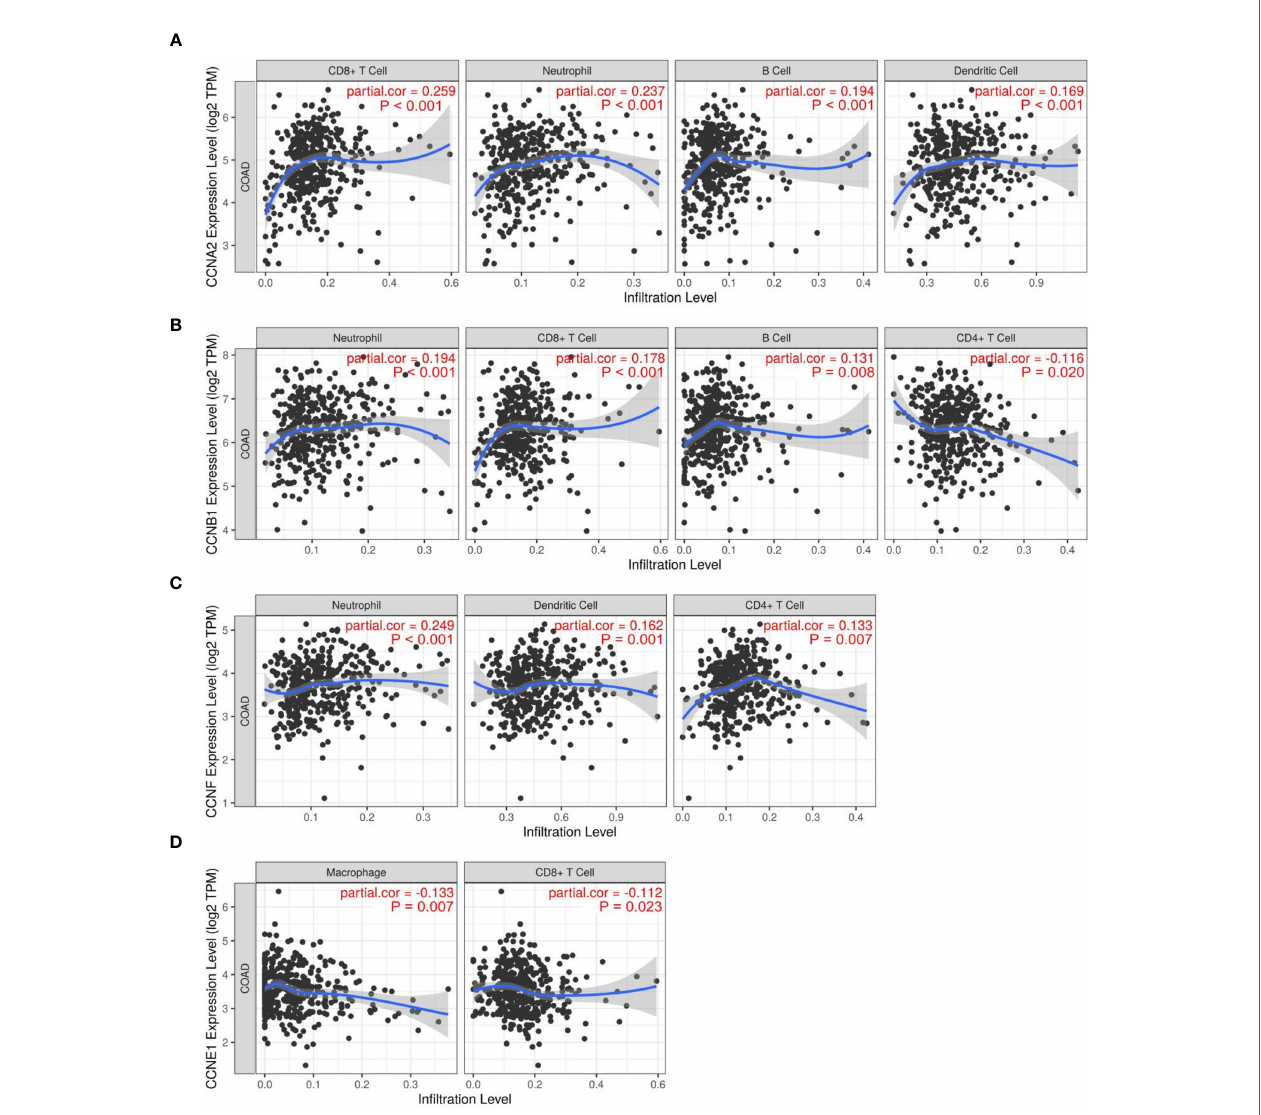
FIGURE 9 | Immune in fi ltration of the four signi fi cant cyclin genes in colon cancer. (A – D) CCNA2 , CCNB1 , CCNE1 , and CCNF were signi fi cantly correlated with immune cells, including CD8+ T cells, CD4+ T cells, neutrophils, B cells, dendritic cells, and